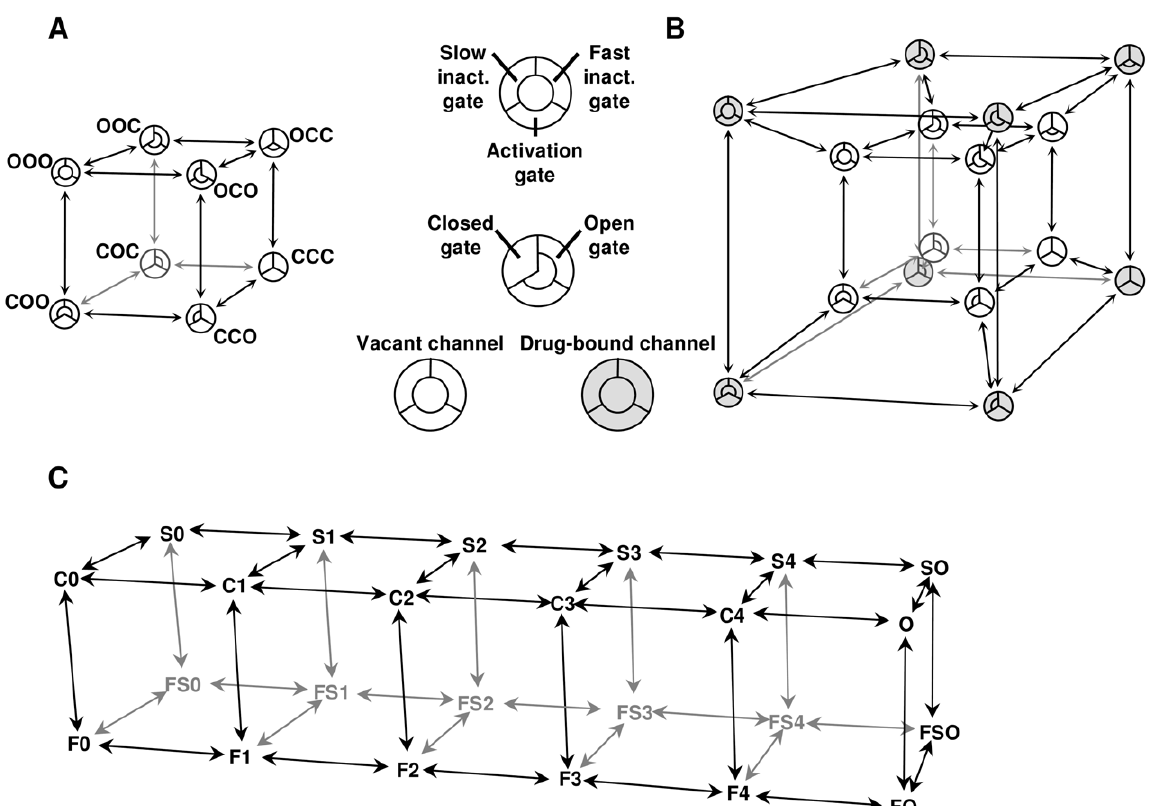
Figure 7. Topology of states in our models, as described in the text. A , Tetracube model of the drug-free channel. The position of the three gates is illustrated as a section of a circle. (This arrangement makes no reference to the structure of sodium channels.) B , Formation of the tetracube: Introduction of drug-bound states into the model. Drug association to all states was allowed. C , ‘‘Multi-step activation’’ (MSA) model of the drug-free